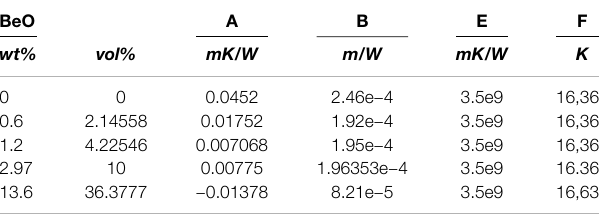
TABLE 2 | Constants for Supplementary Equation (S14)